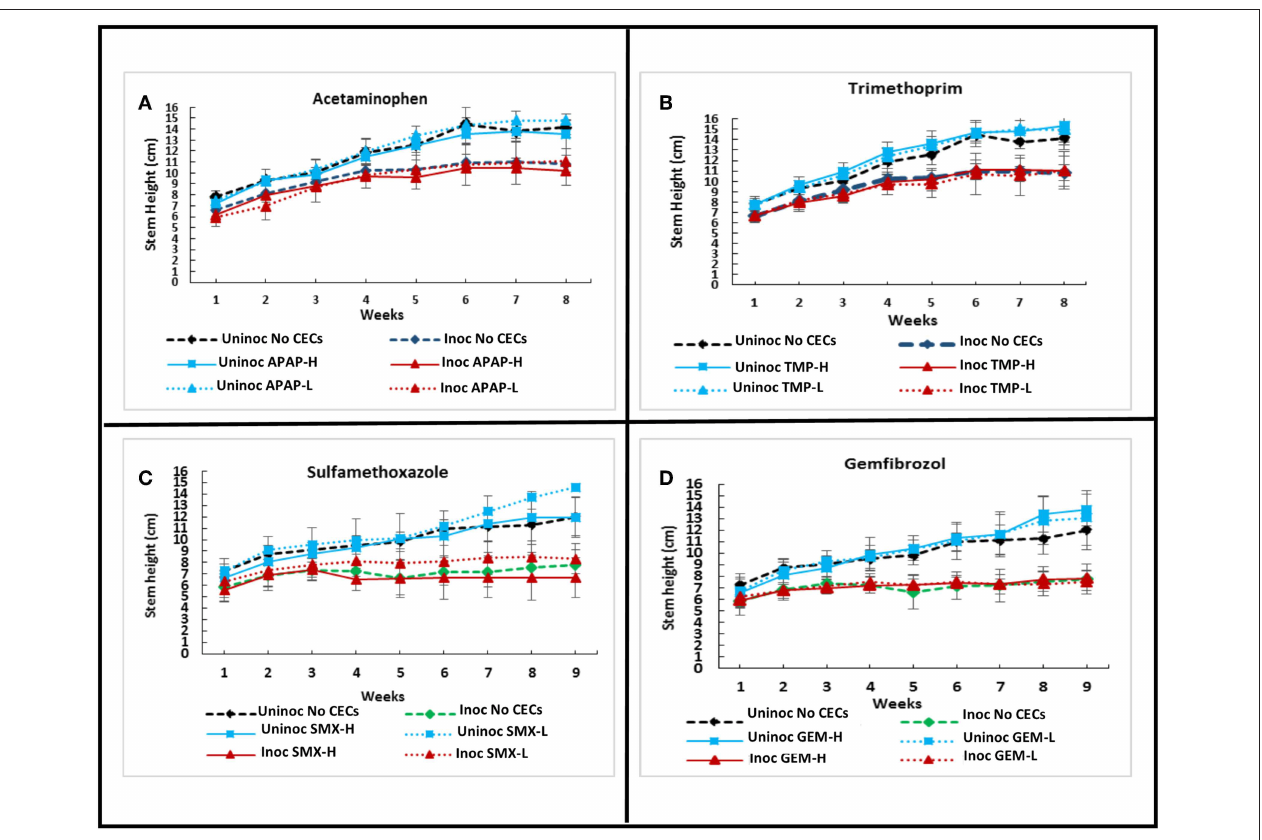
FIGURE 4 | Effects of chemicals of emerging concern (CECs) overtime on stem height of inoculated and uninoculated eggplants grown in the greenhouse. Error bars represent standard deviation. (A) Eggplants treated with acetaminophen (APAP) and a no CEC control. (B) Eggplants treated with trimethoprim (TMP) and the no CEC control. (C) Eggplants treated with sulfamethoxazole (SMX) and a no CEC control. (D) Eggplants treated with gemfibrozil (GEM) and a no CEC control. The same no CEC controls were used for (A,B) , while (C,D) have the same no CEC controls. For each CEC two concentrations were used high (H) and low